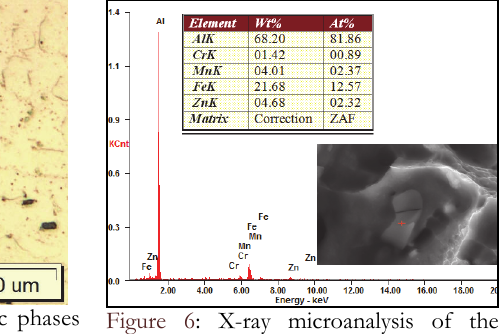
Figure 6: X-ray microanalysis of the chemical composition of precipitation at the bottom of the